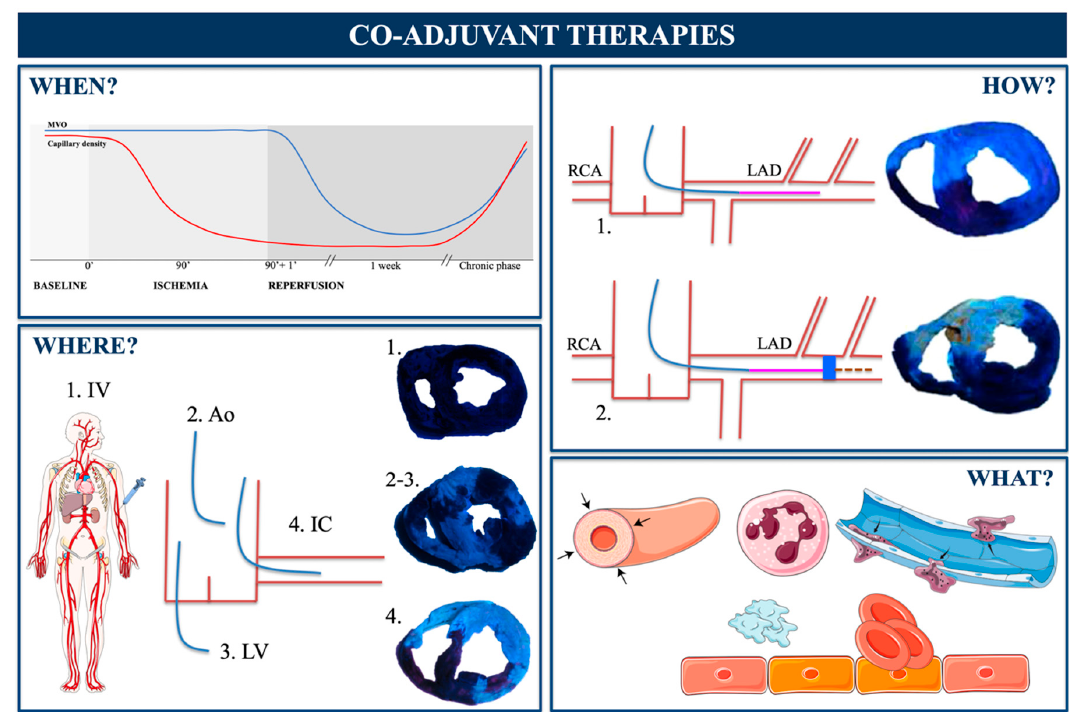
Figure 7. Co-adjuvant therapies beyond reperfusion. Proposed answers to the WH-questions. To optimize the potential effects of any novel co-adjuvant therapies on microvascular obstruction (MVO), the timing (when), the route of administration (where), the technique (how), and the mechanism addressed (what) are crucial. Ao = aorta; IC = intracoronary; IV = intravenous; LAD = left anterior descending; LV = left ventricle; RCA = right coronary artery.